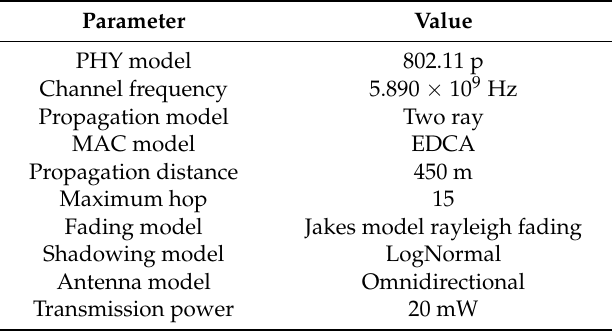
Table 4. Wireless communication parameter.